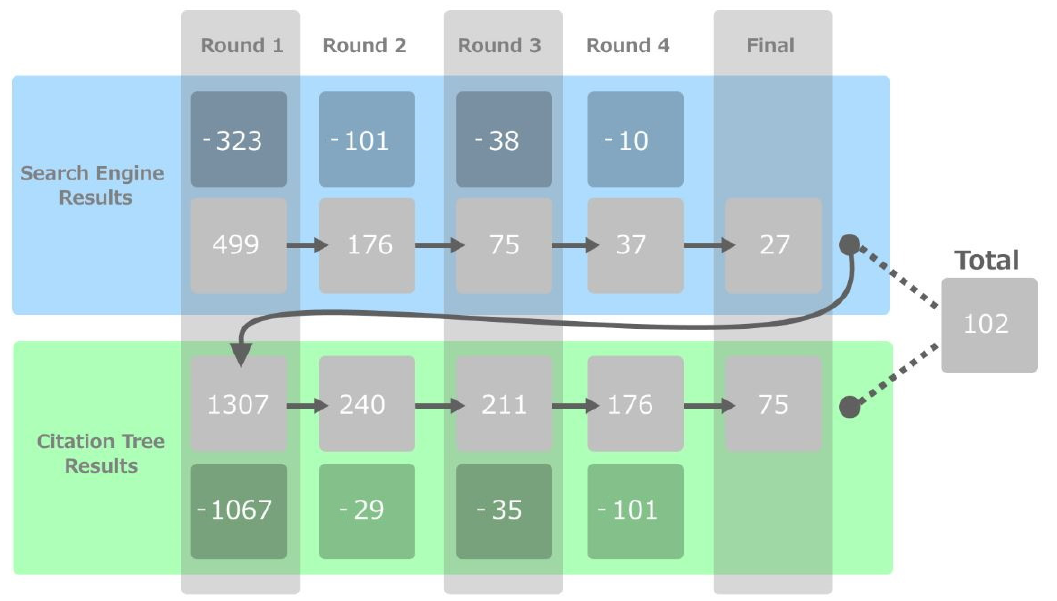
Figure 1. The overall papers included in the review, with points of exclusion for both phases. The blue band represents the search engine round evaluations, and the green band represents the snowballing round